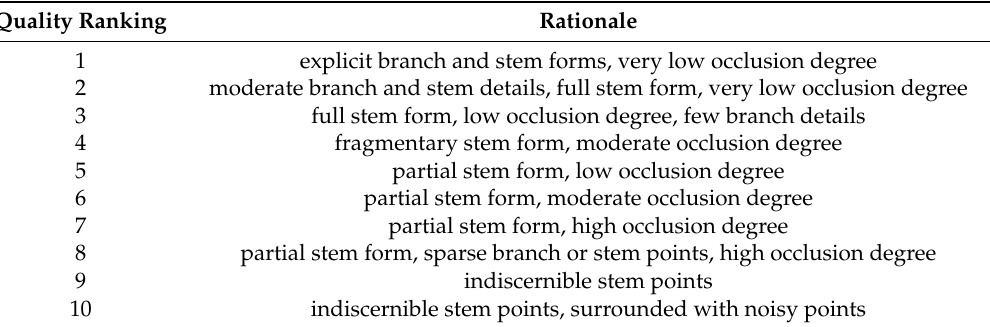
Table 2. Criteria for sample quality ranking.